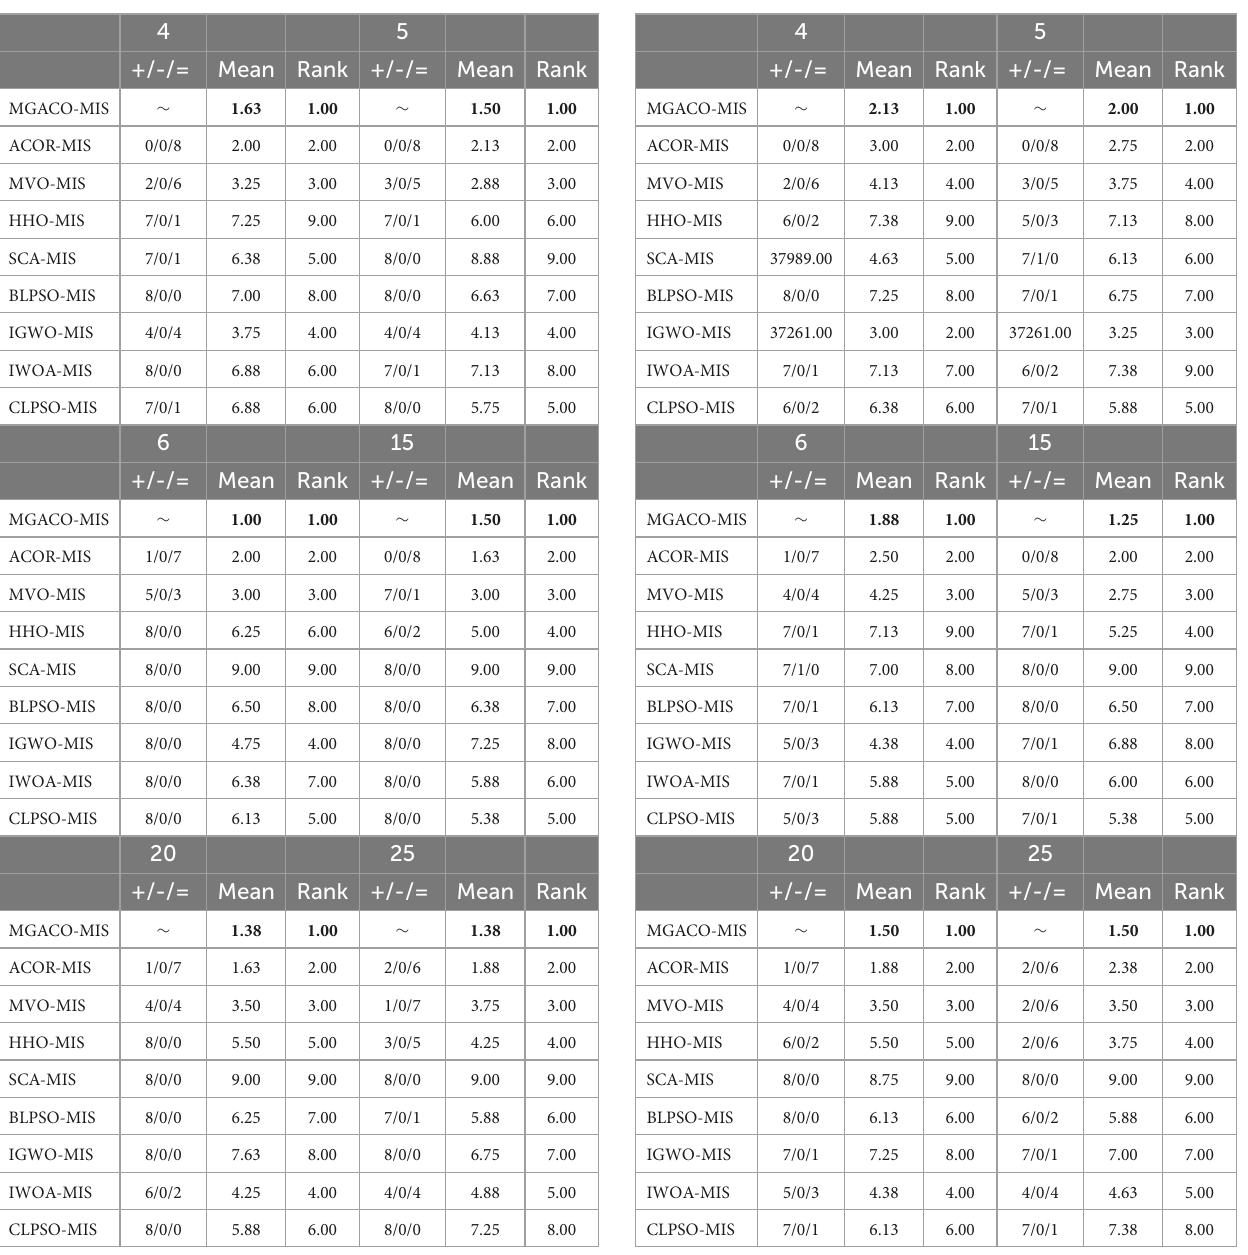
TABLE 5 The FSIM analysis results of MGACO and its peers at different threshold levels.